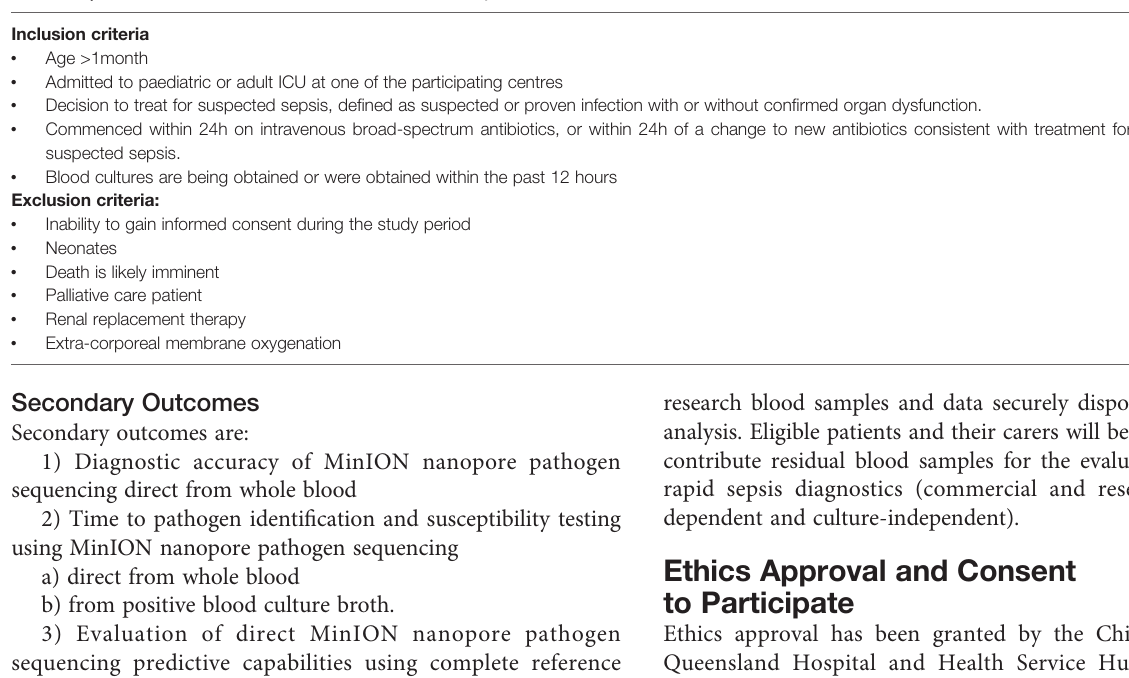
TABLE 1 | Inclusion and exclusion criteria for the DIRECT